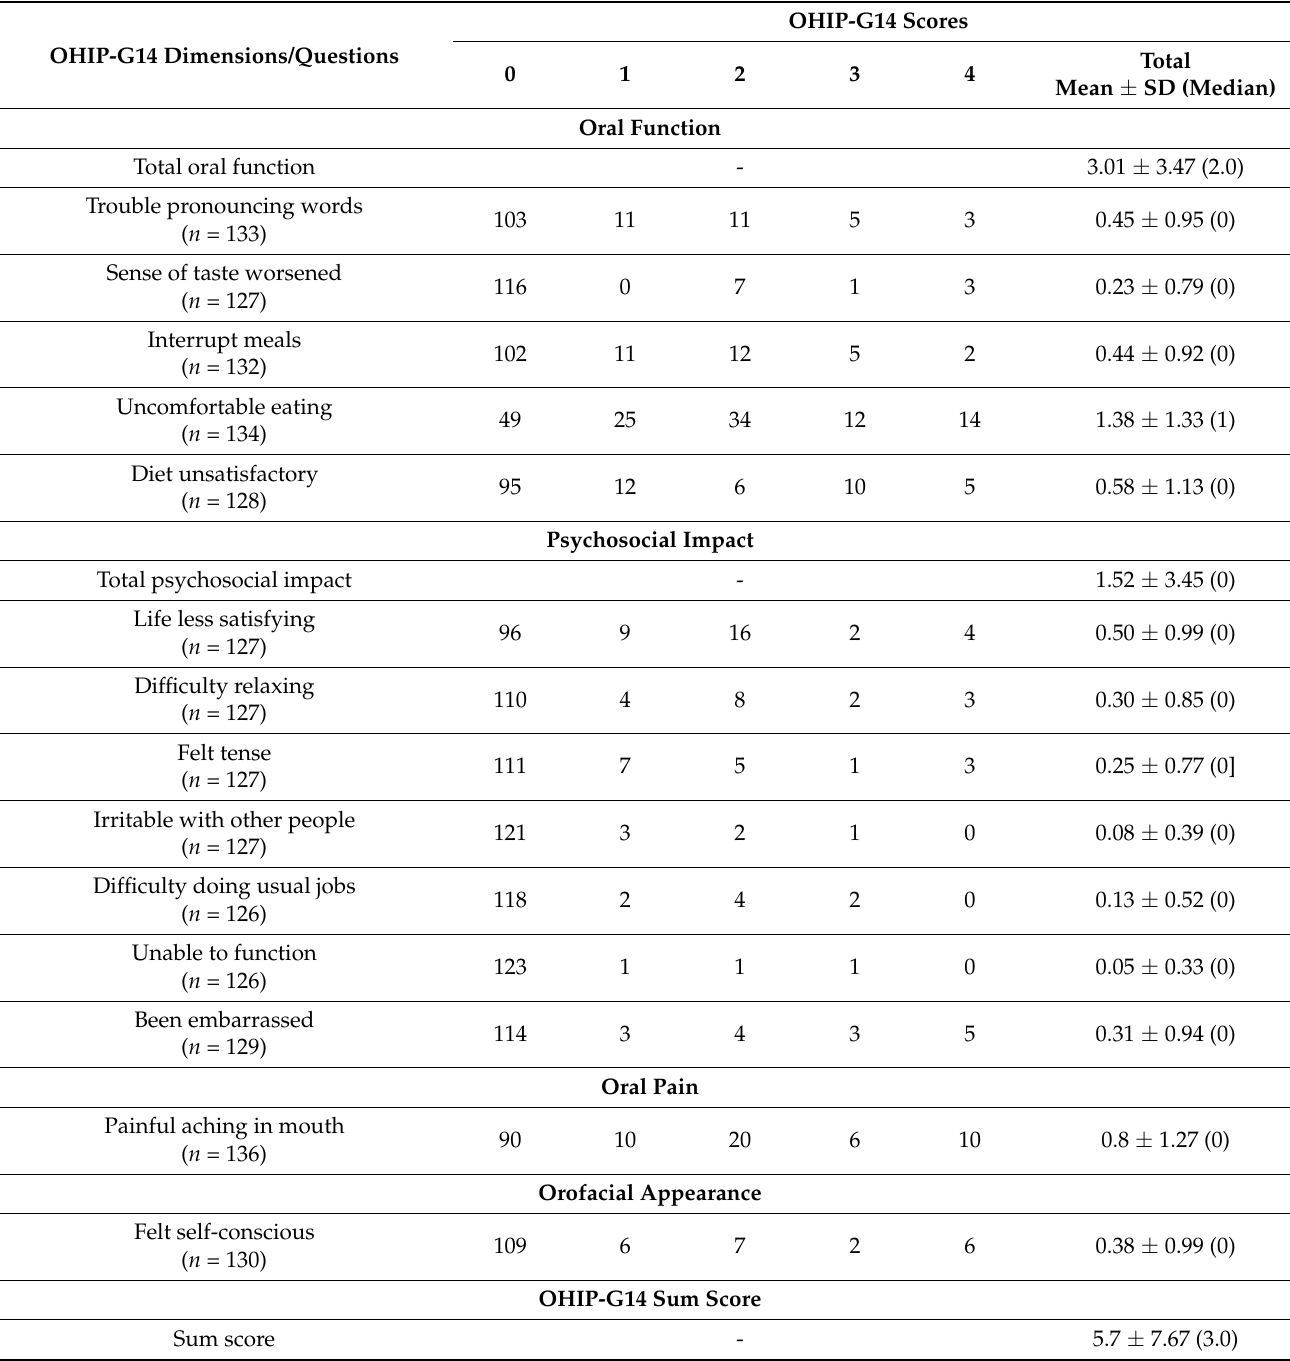
Table 4. Oral health-related quality of life of the participants as assessed using the OHIP-G14. Some of the participants (especially with severe dementia) were not able to complete the questionnaire and were handled as missing values (see n ).